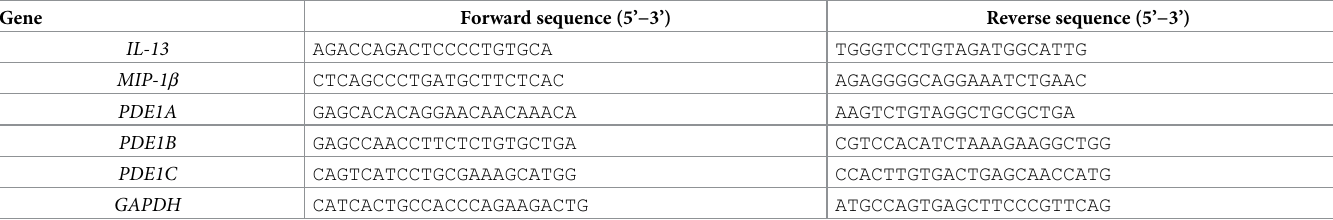
Table 1. The primers used for RT-qPCR in this study.